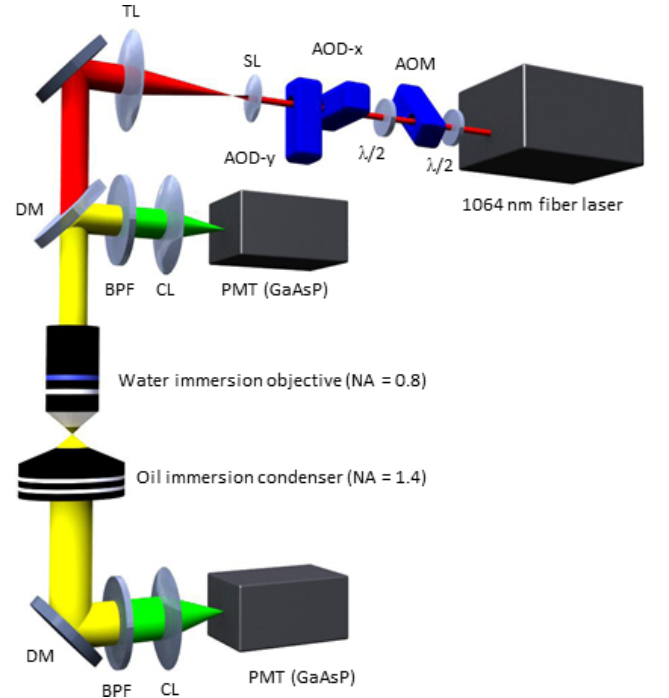
Fig. 8. Random access multi-photon (RAMP) microscope. A ¯ber laser provides the excitation light, which comprises 200 fs width pulses at 80 MHz repetition rate. The laser beam is adjusted for optimal linear polarization via a half-wave ( (cid:2) /2) plate. Beam passes are made through 45 (cid:3) AOM for angular spreading pre-compensation. A second half-wave ( (cid:2) /2) plate is placed after the AOM to optimize the di®raction e±ciencies of the two orthogonally mounted AODs (AOD- x and AOD- y ). A scanning lens (SL) and a microscope tube lens (TL) expand the beam before it is focused onto the specimen by the objective lens. The TPF signal is trans- and epi-collected by an oil immersion condenser and the excitation objective, respectively. Dichroic mirrors (DM) separates excitation and °uorescence light. This latter is then band-pass ¯ltered (BFP) and focused by two collection lenses (CL) into two GaAsP